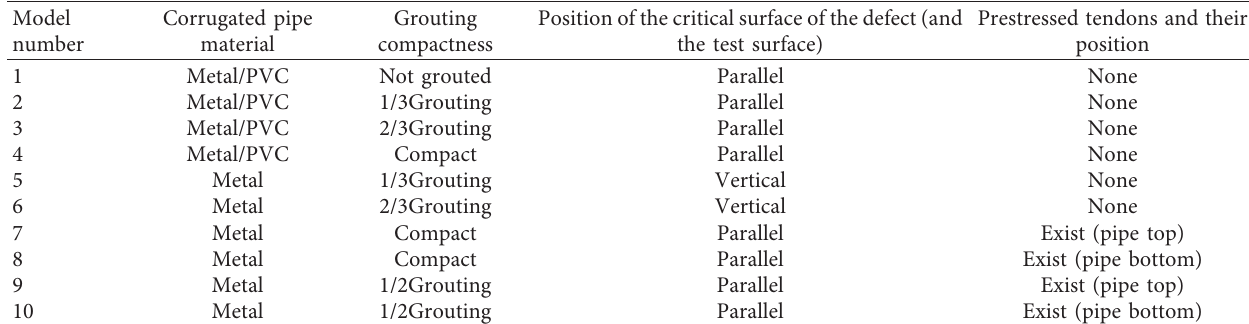
Figure 3 is a partial model diagram. The finite element model is 1.6 m in length, 0.4 m in width, and 0.3 m in height. The pipes are arranged in the central position. The diameter of the pipes is 80 mm, the thickness of the metal wave tube wall is 2 mm, the thickness of the PVC pipe wall is 3 mm, and the diameter of the prestressed steel bar bundle is ap- proximately simulated with a 4 cm steel bar. The working conditions are summarized in Table 2.